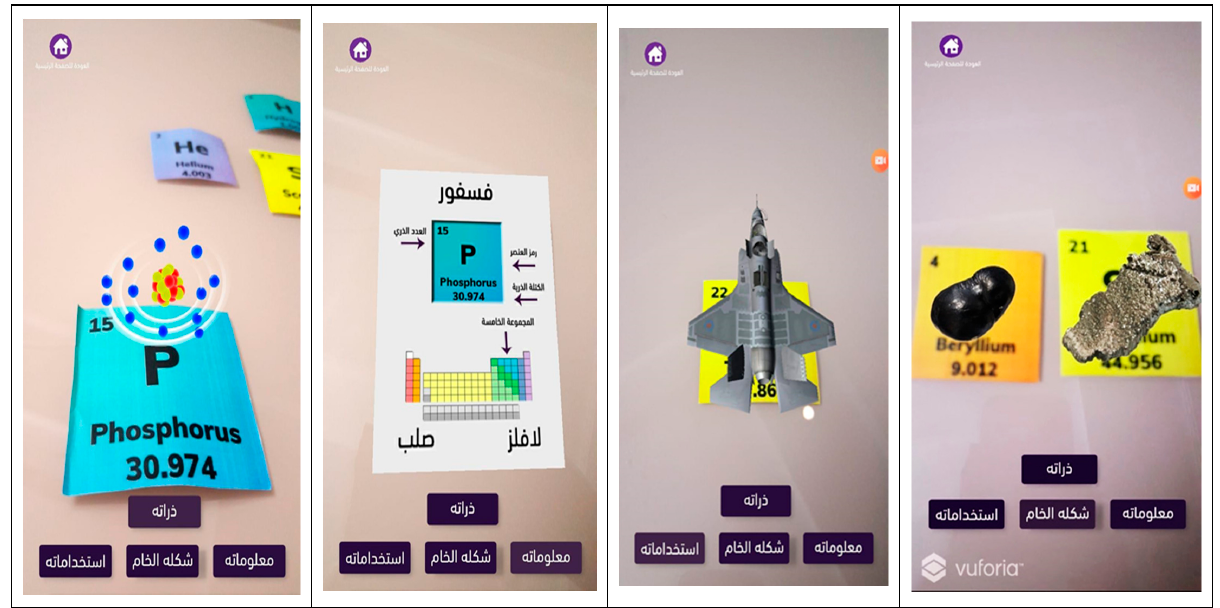
Figure 4. Phosphorus atoms in 3D, general information, raw material in 3D, and its uses in 3D. Table 1. The interfaces of the MicroWorld initial prototype. Interfaces